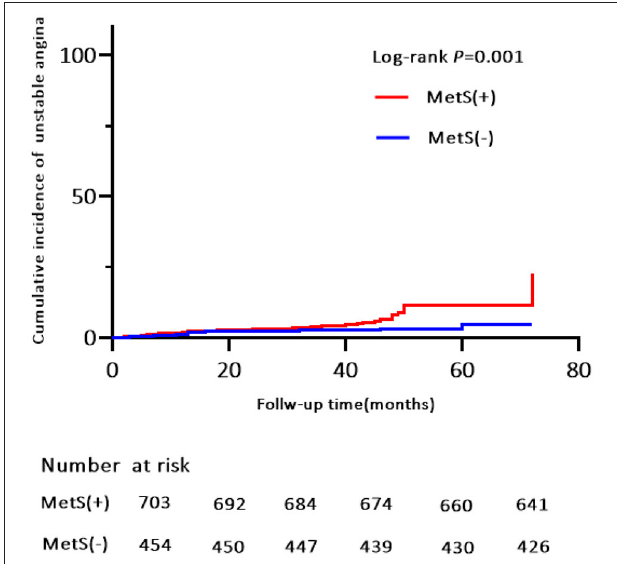
FIGURE 5 | Kaplan-Meier estimates of cumulative incidence (%) for hospitalization for unstable anginaI. Log-rank test, P =